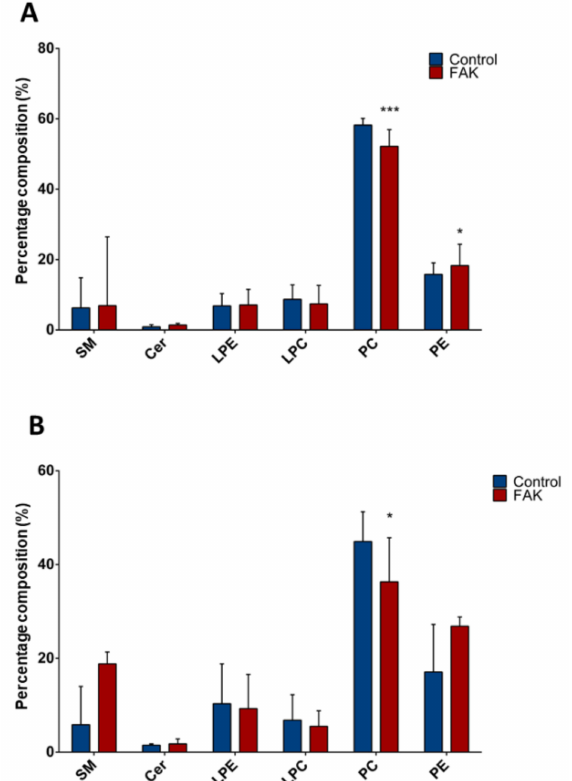
Figure 3. Composition of lipid classes in Huh-7 / HepG2 cells depleted for FAK. ( A ) Percentage composition of lipid classes in KD Huh-7 cells (in red) and control cells (in blue). ( B ) Percentage composition of lipid classes in KD HepG2 cells (in red) and control cells (in blue). Data are represented as median and interquartile range (IQR); * p < 0.05; *** p < 0.001. SM, sphingomyelin; Cer, ceramides, LPE, lysophosphatidylethanolamines; LPC, lysophosphatidylcholines; PC, phosphatidylcholines; PE,